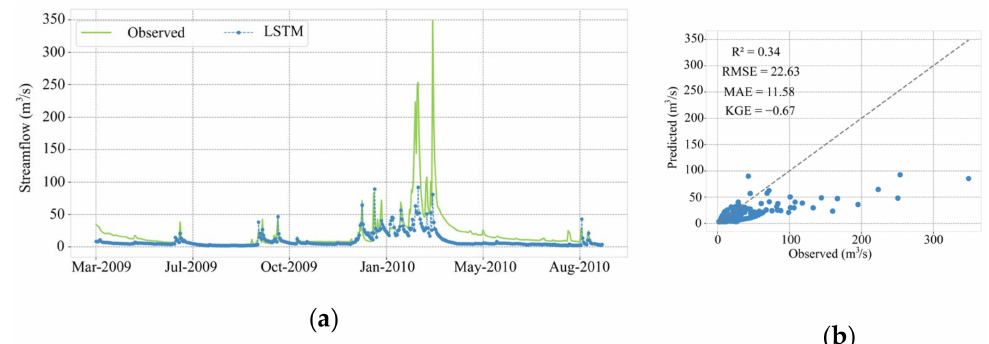
Figure 8. The hydrograph of observed and predicted daily streamflow of LSTM scenario during the testing ( a ) using approach 2 at TS = 25 along with the corresponding scatter plot ( b